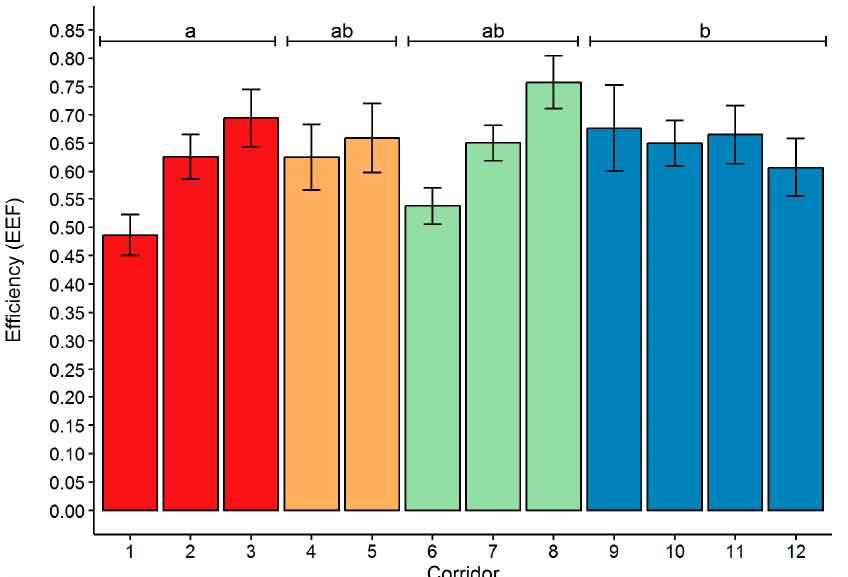
Figure 10. Mean efficiency of yarding cycles per corridor and campaign based on the EEF [28] ( y -axis), with corresponding confidence intervals (95%) for each corridor ( x -axis) in campaign red ; campaign orange ; campaign green ; and campaign blue . Different lower case letters indicate significant differences between campaign means (Kruskal-Wallis and post-hoc pairwise comparison Nemenyi-test with χ 2 -approximation, p < 0.05).